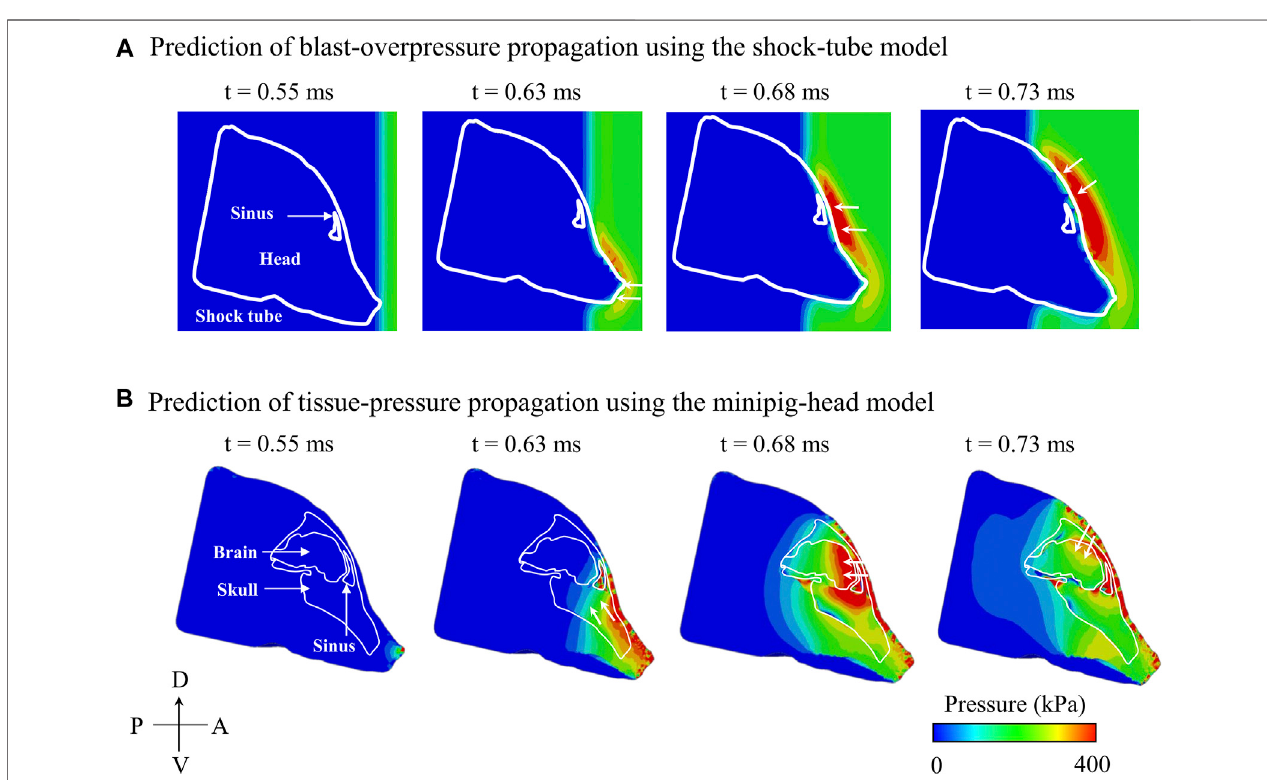
FIGURE6| Predictedtemporalandspatialpropagationofblastoverpressure(BOP) andtissuepressurebasedonthe (A) shock-tubemodeland (B) minipig-head model, respectively, along the mid-sagittal plane. (A) Based on the shock-tube model, at time t (cid:1) 0.55 ms, the BOP reached and loaded the head. At time t (cid:1) 0.63 ms, the BOP loaded the snout (white arrow); at time t (cid:1) 0.68 ms, the BOP traversed and loaded the forehead near the sinus (white arrow); and at time t (cid:1) 0.73 ms, the BOP loaded the top of the head (white arrow). (B) Based on the minipig-head model, at time t (cid:1) 0.55 ms, the pressure started to load the brain tissues. At time t (cid:1) 0.63 ms, the pressure in the snout traveled through the skull and loaded the brain (white arrows); at time t (cid:1) 0.68 ms, the pressure from the forehead entered the sinus cavityandloadedthebrain(whitearrows);andattimet (cid:1) 0.73 ms,thepressurefromthetopoftheheadenteredthroughtheskullandloadedthebrain(whitearrows).A: anterior; D: dorsal; P: posterior; V: